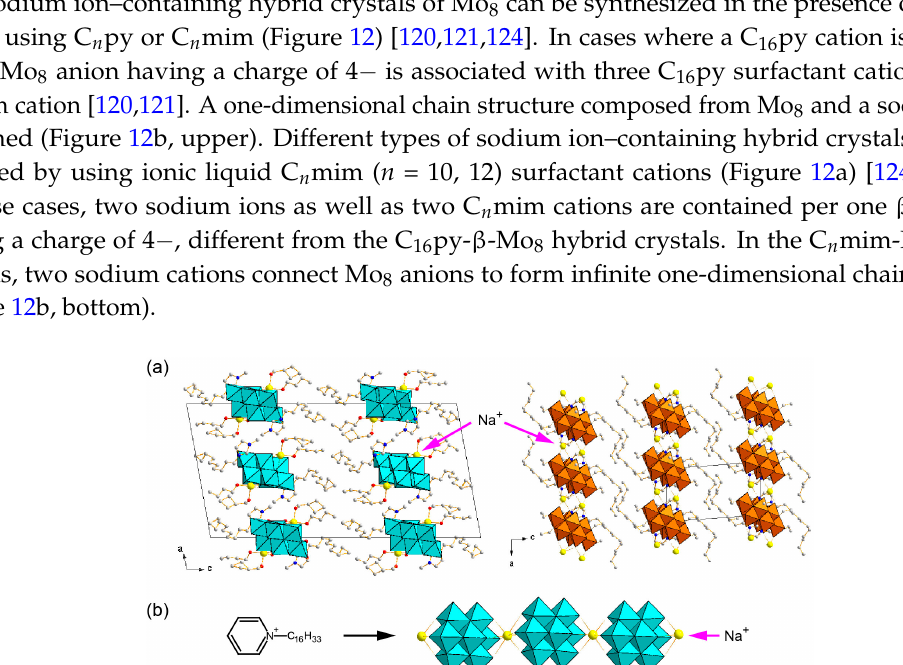
Figure 12. Sodium ion-containing POM-surfactant crystals. ( a ) C 10 mim- β -Mo 8 (left) and C 12 mim- γ -Mo 8 (right); ( b ) difference in the arrangements of β -Mo 8 anion and sodium cation depending on the surfactant cation [120,121,124]. Reproduced with permission from Ito, T. et al. , Chem. Lett.; published by The Chemical Society of Japan, 2010; from Ito, T. et al. , Chem. Lett. ; published by The Chemical Society of Japan, 2011; and from Ito, T. et al. , Crystals; published by MDPI, 2014. Conductive property has been investigated for some POM-surfactant hybrid crystals. The measurements were carried out using the alternating current (AC) impedance method for a pelletized sample under an anhydrous atmosphere at intermediate temperature. Electronic conductivities for hybrid crystals of C 16 py-W 10 (Figure 13) [127] and C 16 py-Mo 4 [129] are in the range of 10 − 6 to 10 − 5 S cm − 1 order. Although these values are much lower than the radical salts of POM containing an organic donor [8,9], POM-surfactant crystals with an appropriate combination of POMs and surfactants